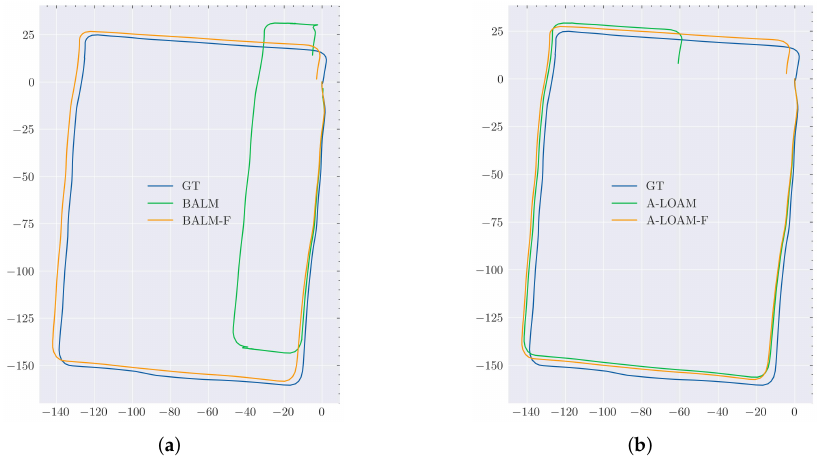
Figure 9. There are clearly large errors in the origins of BALM ( a ) and A-LOAM ( b ). By replacing the feature extraction module with our scheme, the new algorithms, BALM-F ( a ) and A-LOAM-F ( b ), achieve impressive performance